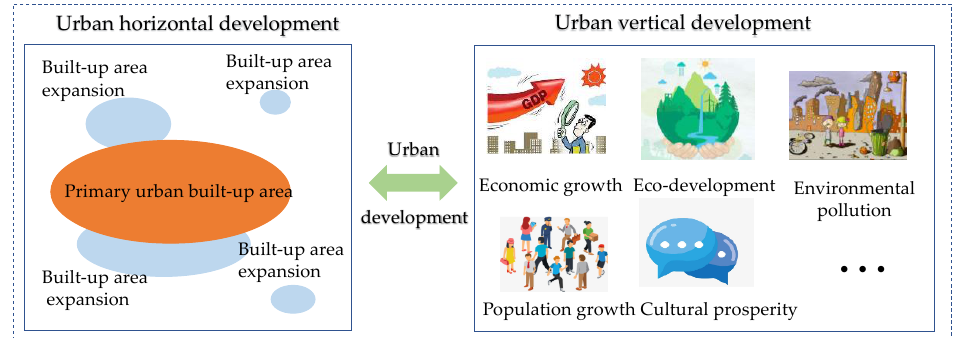
Figure 1. Framework of urban development.